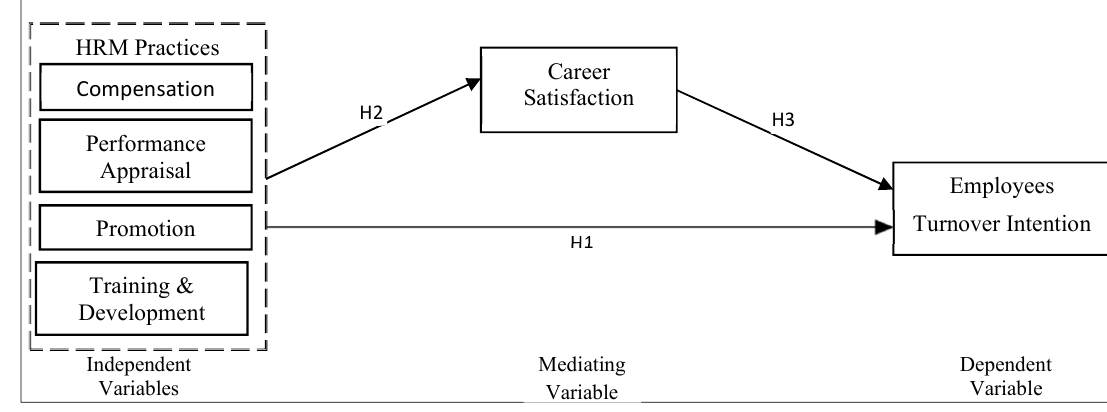
Fig. 1. Research Model